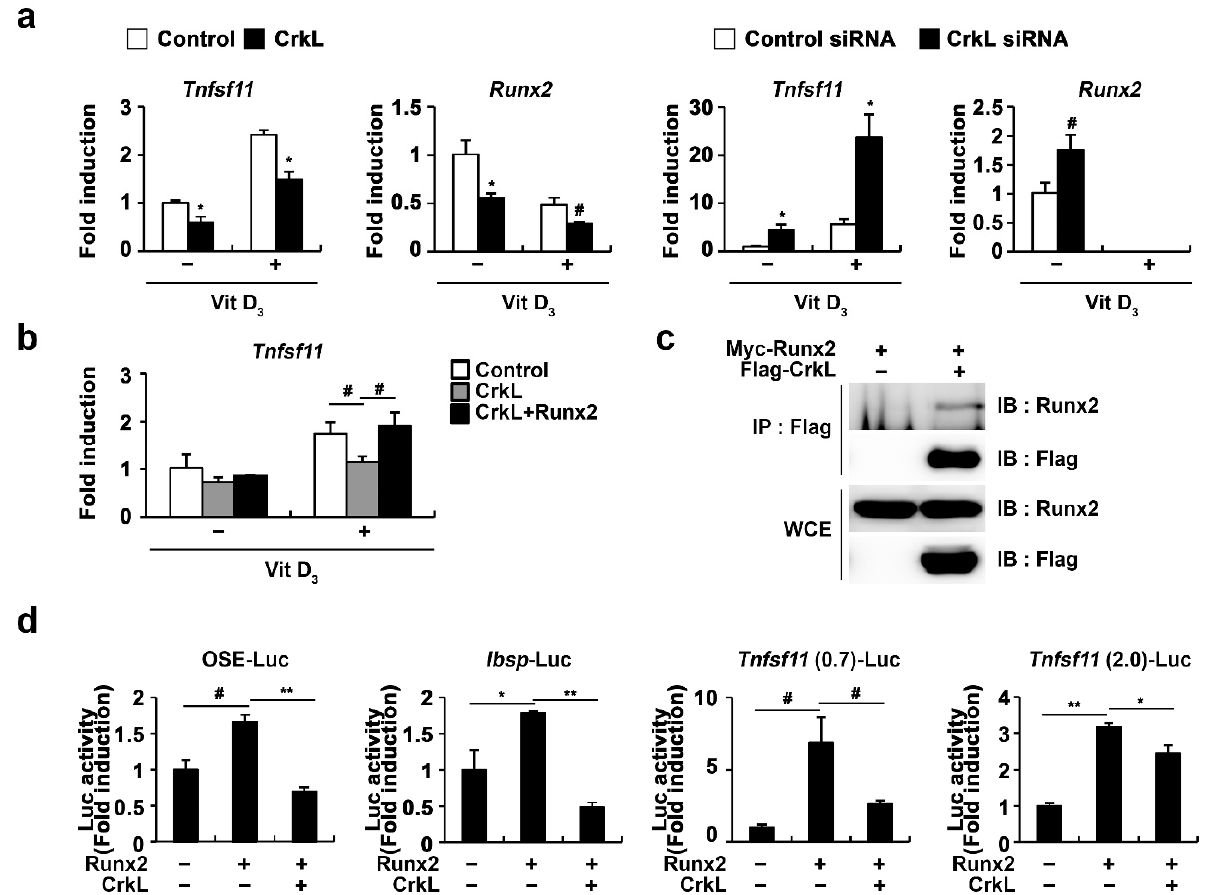
Figure 4. CrkL inhibits Runx2 transcriptional activity. ( a ) Primary osteoblast precursors overexpressing control or CrkL retrovirus and primary osteoblast precursors transfected with control or CrkL-siRNAs were cultured in the presence or absence of Vit D 3 . ( b ) Primary osteoblast precursors overexpressing control, CrkL or CrkL and Runx2 were cultured in the presence or absence of Vit D 3 . mRNA expression of Tnfsf11 . ( c ) Co-immunoprecipitation assays in Runx2 or Runx2 and CrkL-transfected HEK-293T cells. ( d ) Luciferase assay of HEK-293T cells transfected with various expression